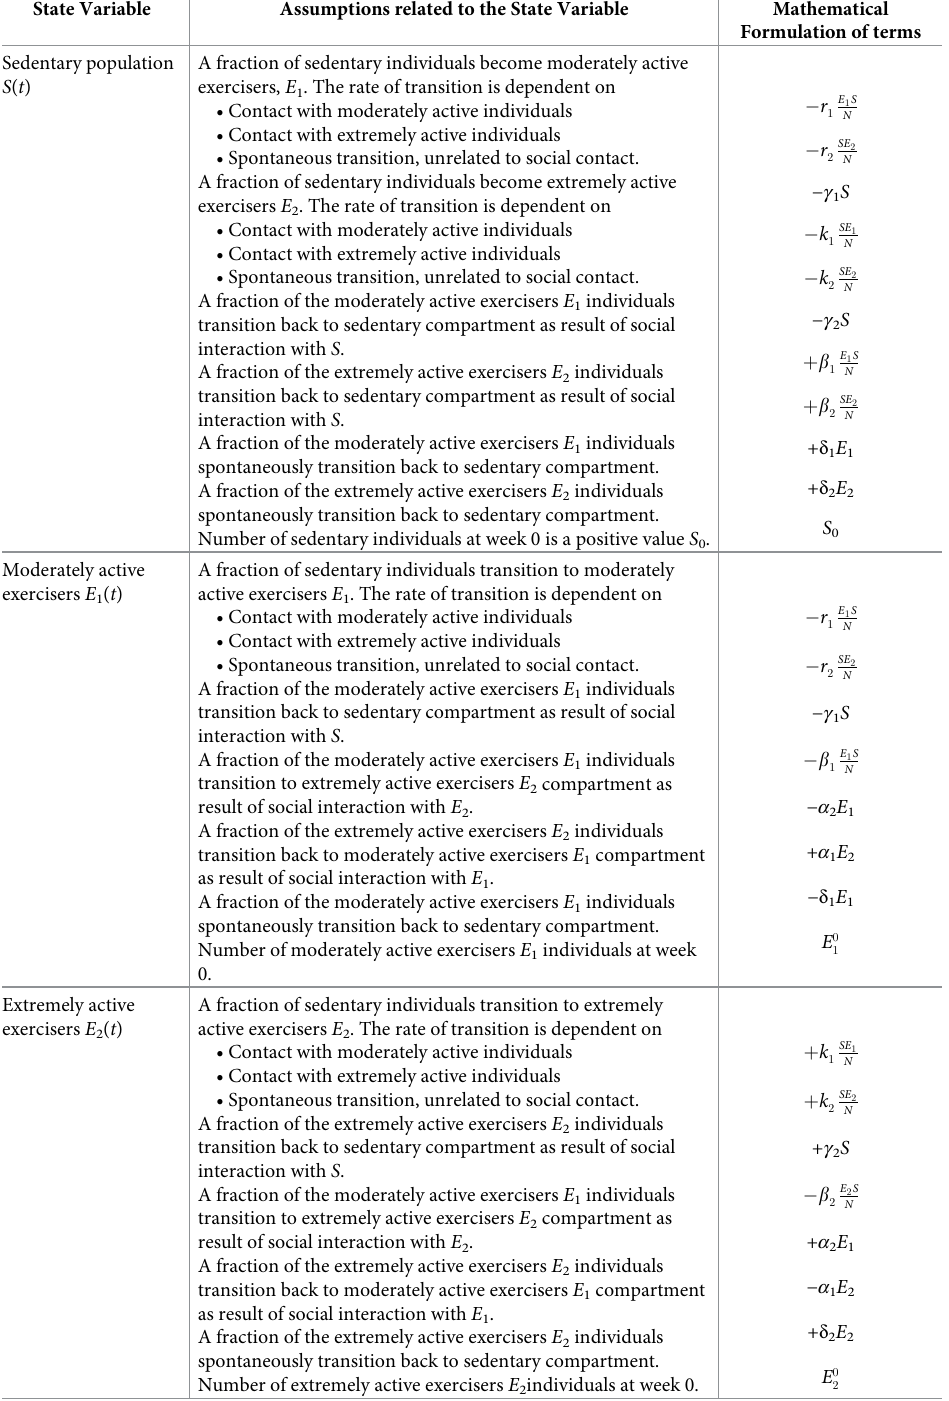
Table 2. Description of all model state variables and assumptions related to the state variable and terms of the state